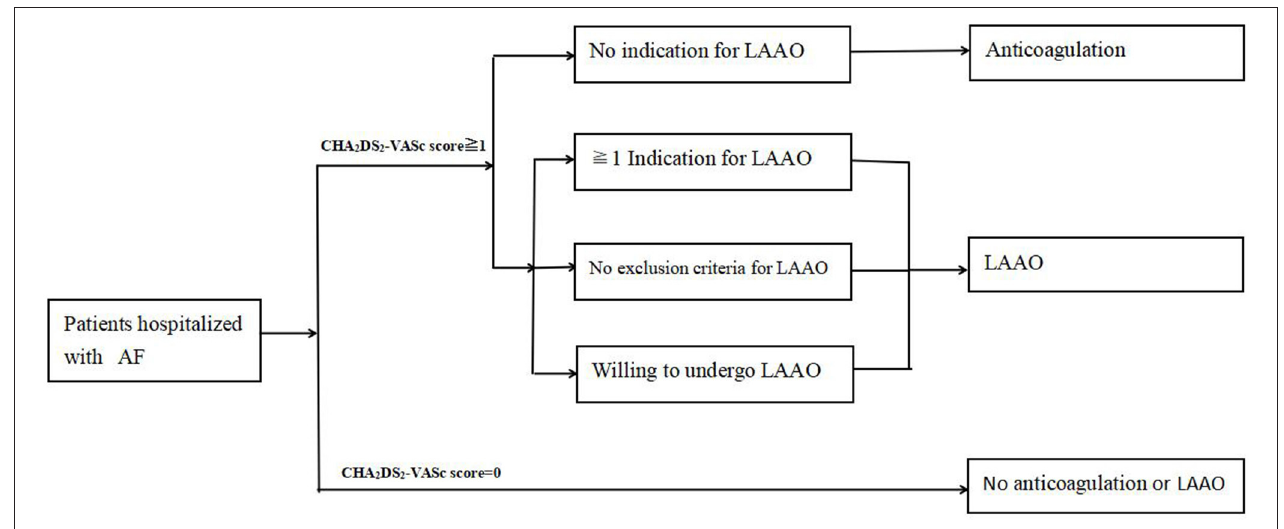
FIGURE 1 | Flow chart of patient